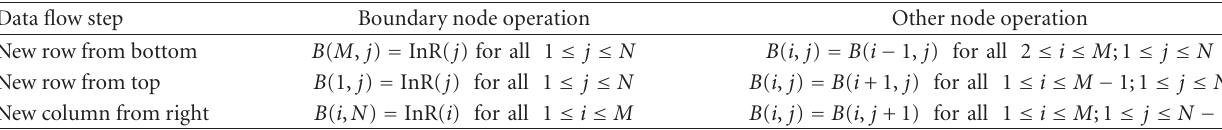
Table 2: 2-D CRA operation based on data flow during one control step.